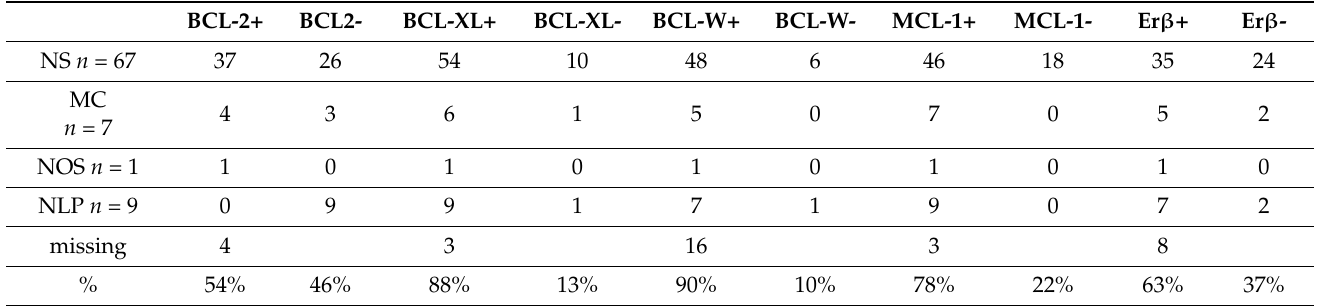
Table 1. Immunohistochemistry results of Hodgkin lymphoma cases for anti-apoptotic proteins and ER β